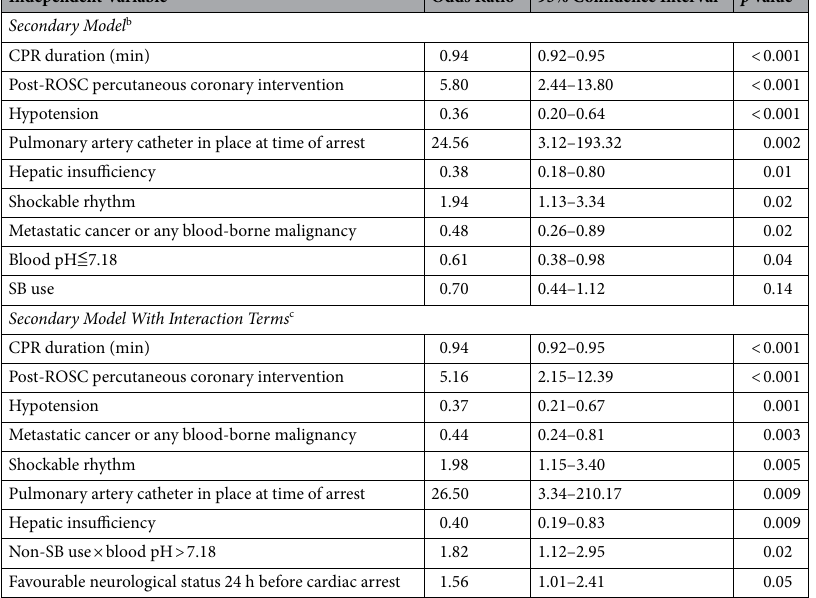
Table 4. Multiple Logistic Regression Model With Survival at Hospital Discharge as the Dependent Variable. Abbreviations: CPR, cardiopulmonary resuscitation; ROSC, return of spontaneous circulation; SB, sodium bicarbonate. a The display of independent variables is arranged in order of p value. b Secondary model: goodness-of-fit assessment: n = 1060, adjusted generalised R 2 = 0.34,estimated area under the receiver operating characteristic curve = 0.85, and Hosmer and Lemeshow goodness-of-fit Chi-Squared test p = 0.10. c Secondary model with interaction terms: goodness-of-fit assessment: n = 1060, adjusted generalised R 2 = 0.36, estimated area under the receiver operating characteristic curve = 0.85, and Hosmer and Lemeshow goodness-of-fit Chi- Squared test p =